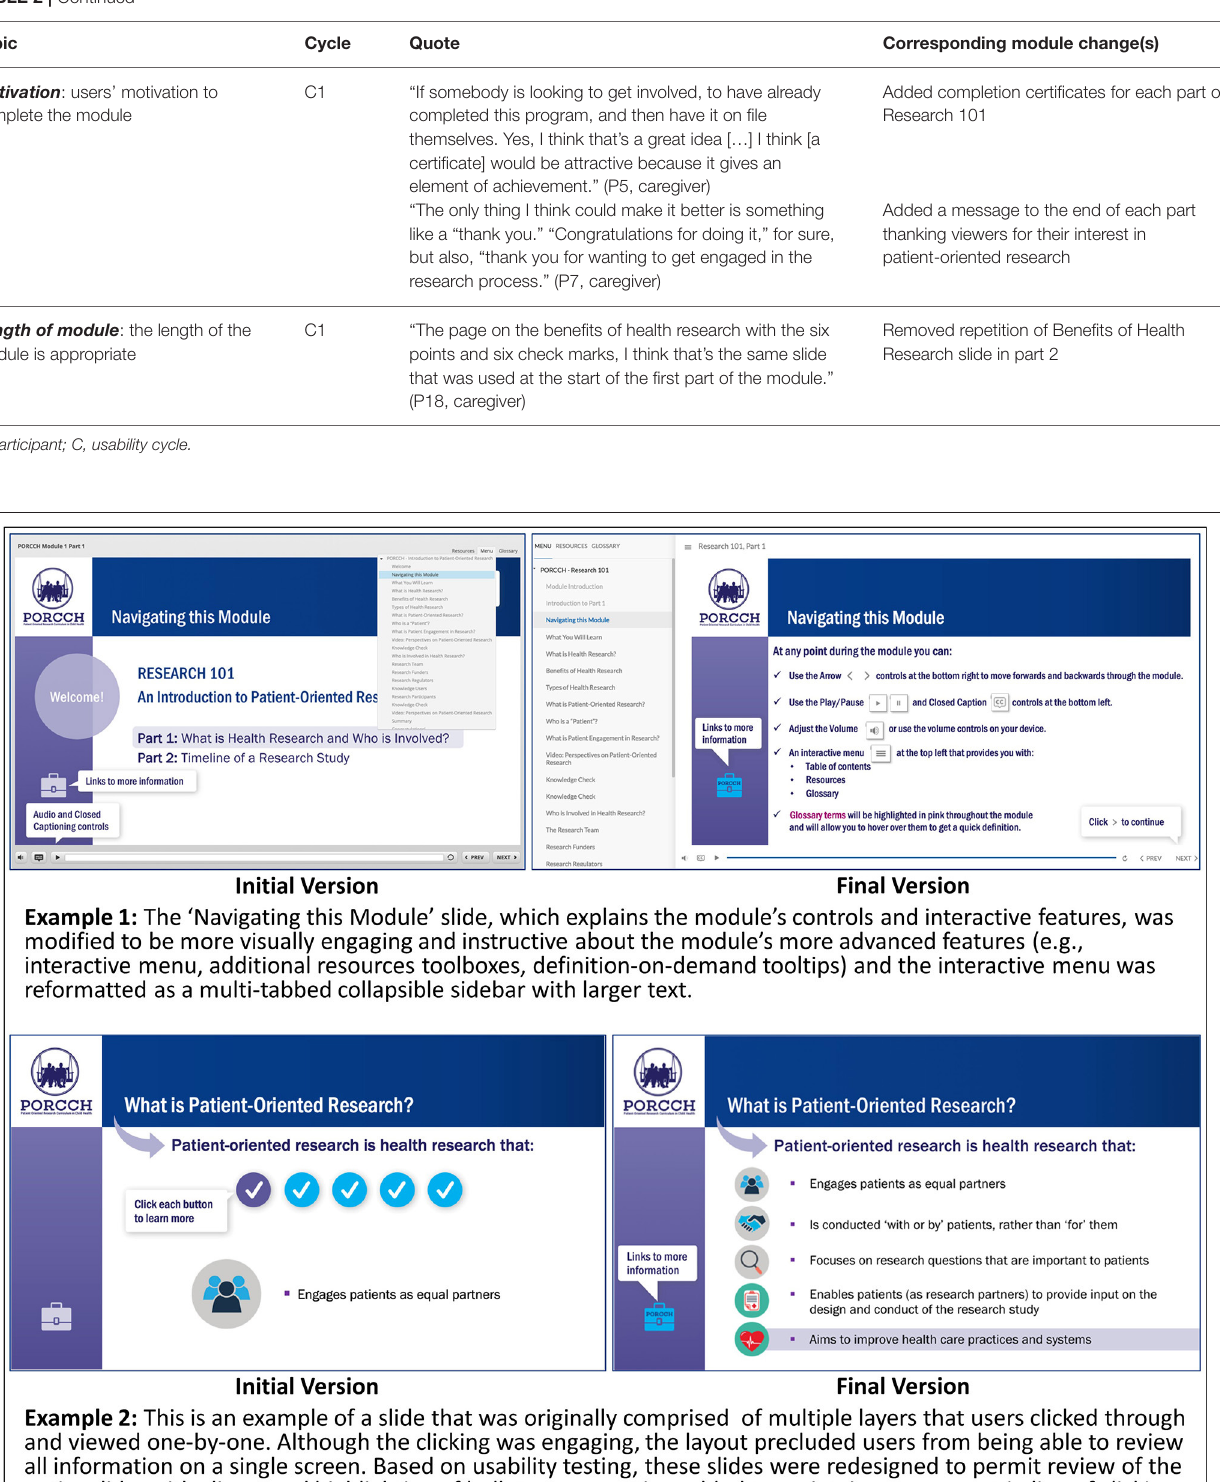
FIGURE 1 | Example modifications made to the e-learning module in response to usability